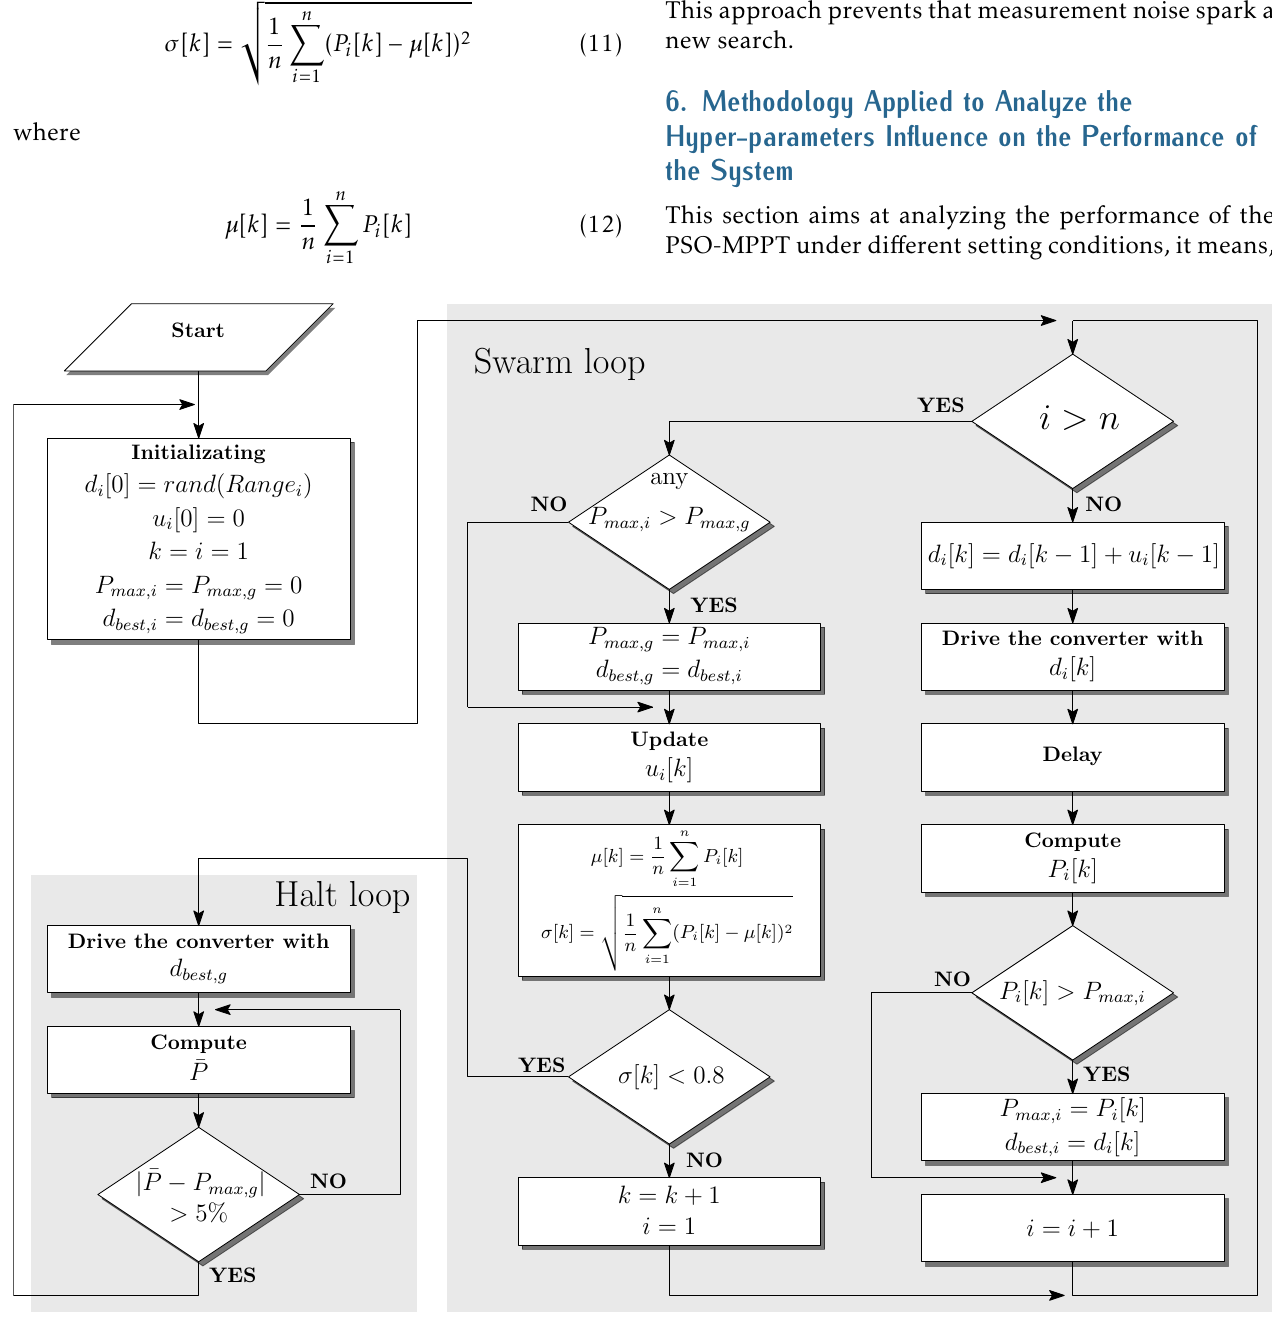
Figure 6. Particle swarm algorithm flowchart for n particles. The swarm loop represents the process of going from particle to particle testing the power response. The halt loop goes off whenever the particles converge to GMPP. It was decided not to show the limiter of d in this diagram for the sake of i